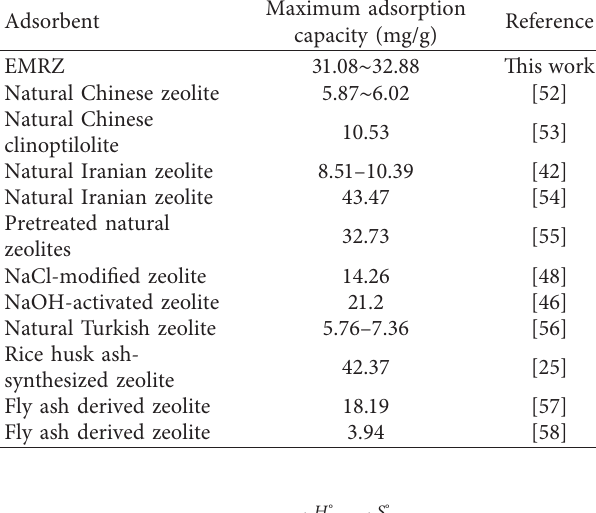
Table 3: Comparison of maximum adsorption capacity of am- monium on various